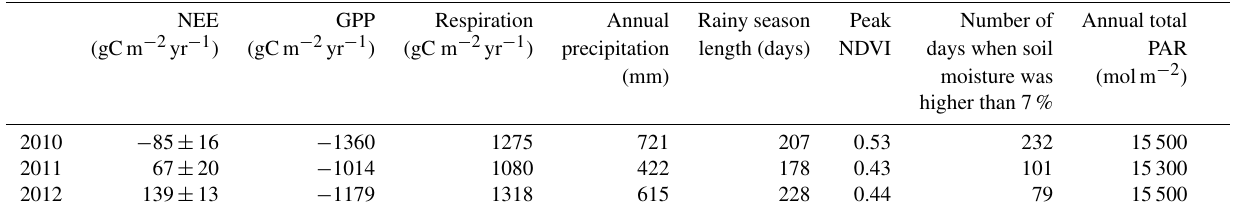
Table 3. Annual carbon balance and key environmental drivers calculated for each year from September to the August of the following year.